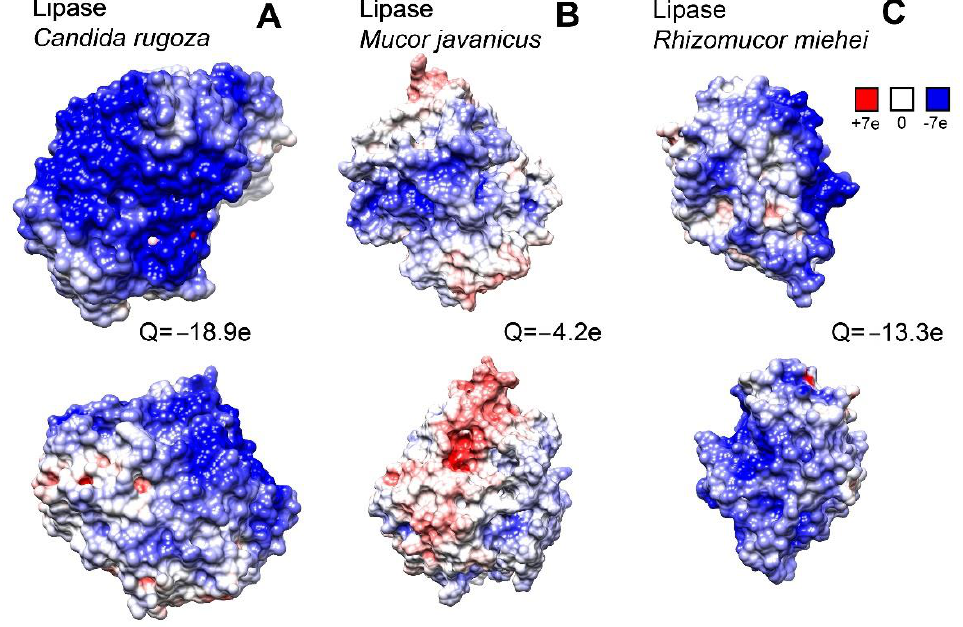
Figure 1. Lipase release from κ -carrageenan-based hydrogel microspheres.